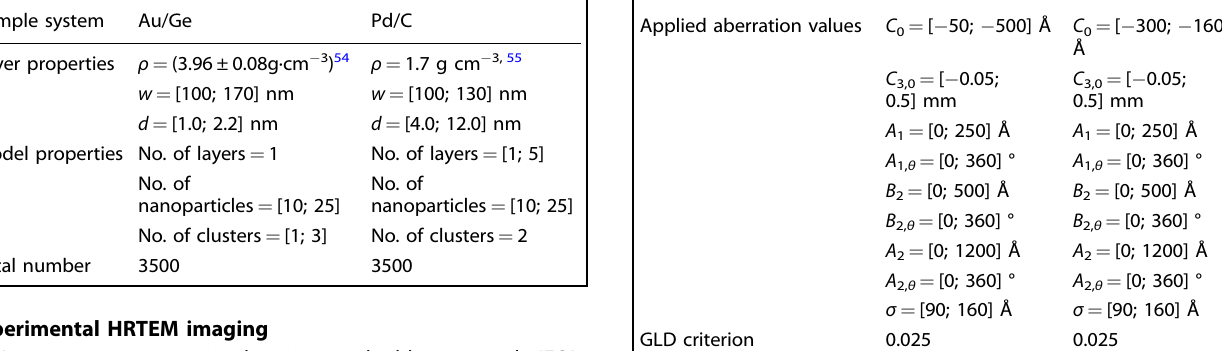
Table 2. Properties of computationally generated sample system models.